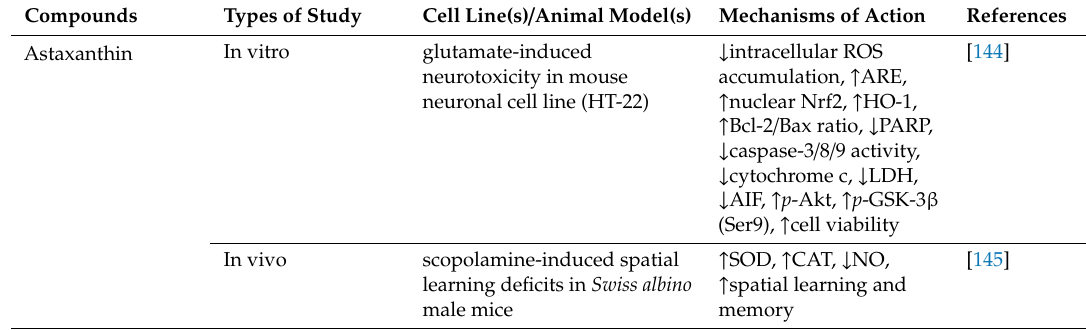
Table 4. Carotenoids combating AD through Nrf2 / Keap1 / ARE and interconnected pathways.